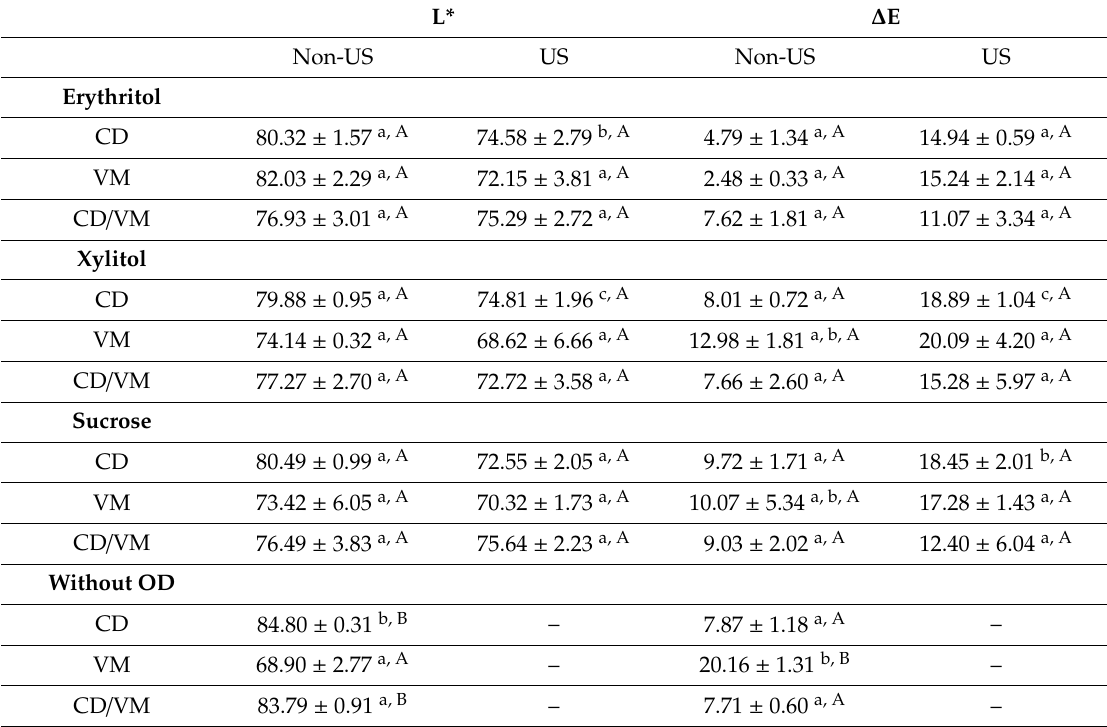
Table 3. Values of the L * parameter characterizing brightness and absolute color di ff erences ( ∆ E) in dried apple obtained by various methods. Means within one column with a di ff erent letter superscript are significantly di ff erent – homogeneous groups ( p < 0.05). Lowercase (a, b and c) —factor: osmotic substance / without OD, among the same drying method; uppercase (A and B) – factor: drying method, among the same osmotic